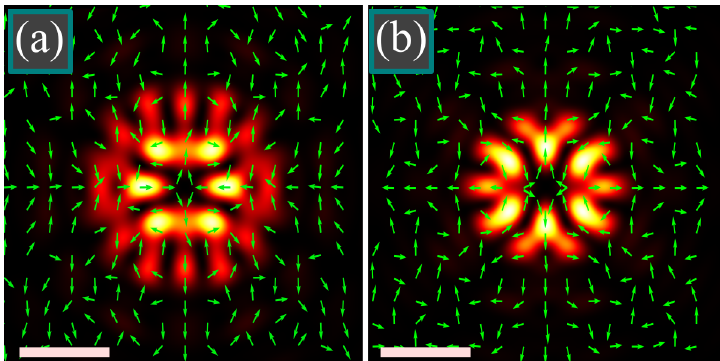
Figure 6. Intensity distribution and polarization directions of a tightly focused light field with double-index polarization singularity of the orders ( m , n ) = (3, 7) ( a ) and ( m , n ) = (5, 3) ( b ) at the following parameters: wavelength λ = 532 nm, focal length of the lens f = 10 µ m, numerical aperture sin α = 0.95, radial apodization function is A ( θ ) ≡ 1. Scale mark shows 1 μ m.